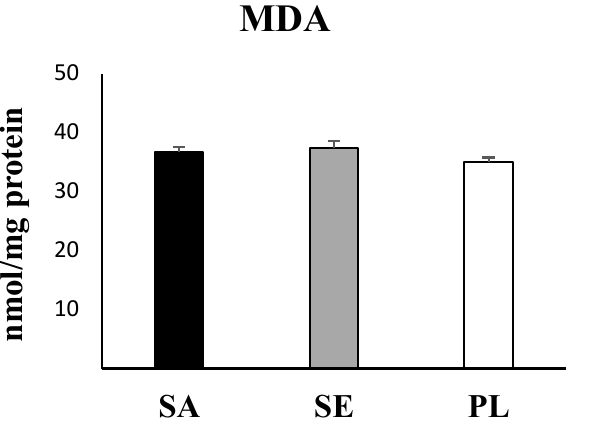
Figure 7. Malondialdehyde (MDA) levels in the digestive tract of H. tubulosa . No significant differences were observed. SA, Sant Antoni de Portmany; SE, Santa Eul à ria des Riu; PL, Pou des Lle ó . Significant differences in the activity of CAT were found between Sant Antoni de Portmany and Pou des Lle ó (LSD, p < 0.05), with a mean value of 30.5 ± 5.4 mK/mg protein in Sant Antoni de Portmany and 18.2 ± 3 mK/mg protein in Pou des Lle ó . A similar response pattern was observed in the SOD and GSH activities, evidencing significantly higher values (LSD, p < 0.05) in guts of animals collected from Sant Antoni de Portmany (SOD: 8.3 ± 1.5 pKat/mg; GSH: 22.1 ± 2.9 µ mol/mg protein) than in the gut of animals from Pou des Lle ó (SOD: 5.5 ± 0.2 pKat/mg protein; GSH: 20.1 ± 1.3 µ mol/mg protein). Moreover, GST and GRd activities were significantly higher in Sant Antoni de